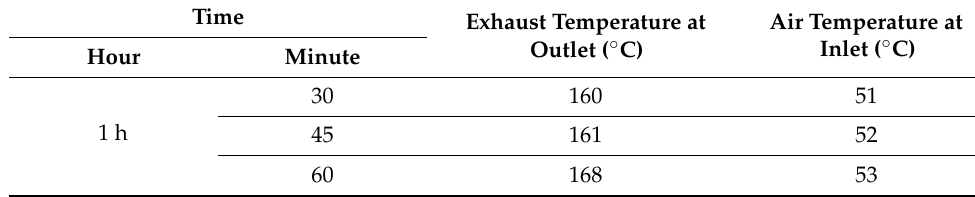
Table 3. Temperature values recorded during tests of the chimney’s thermal